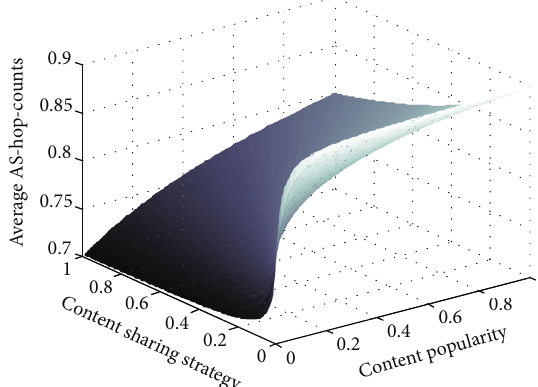
Figure 8: Content delivery cost in tit-for-tat